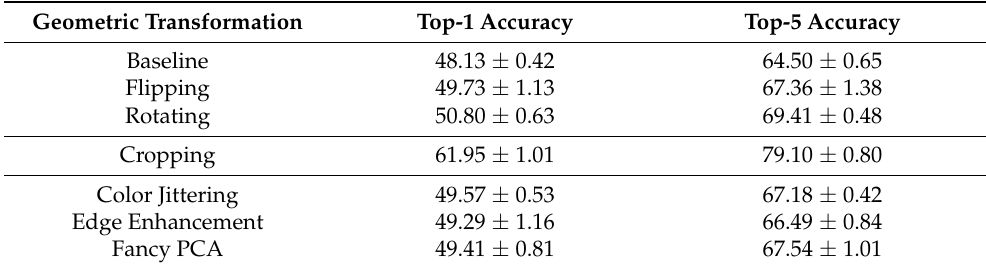
Table 1. Results of Taylor and Nitschke’s geometric transformation experiments (units: %)